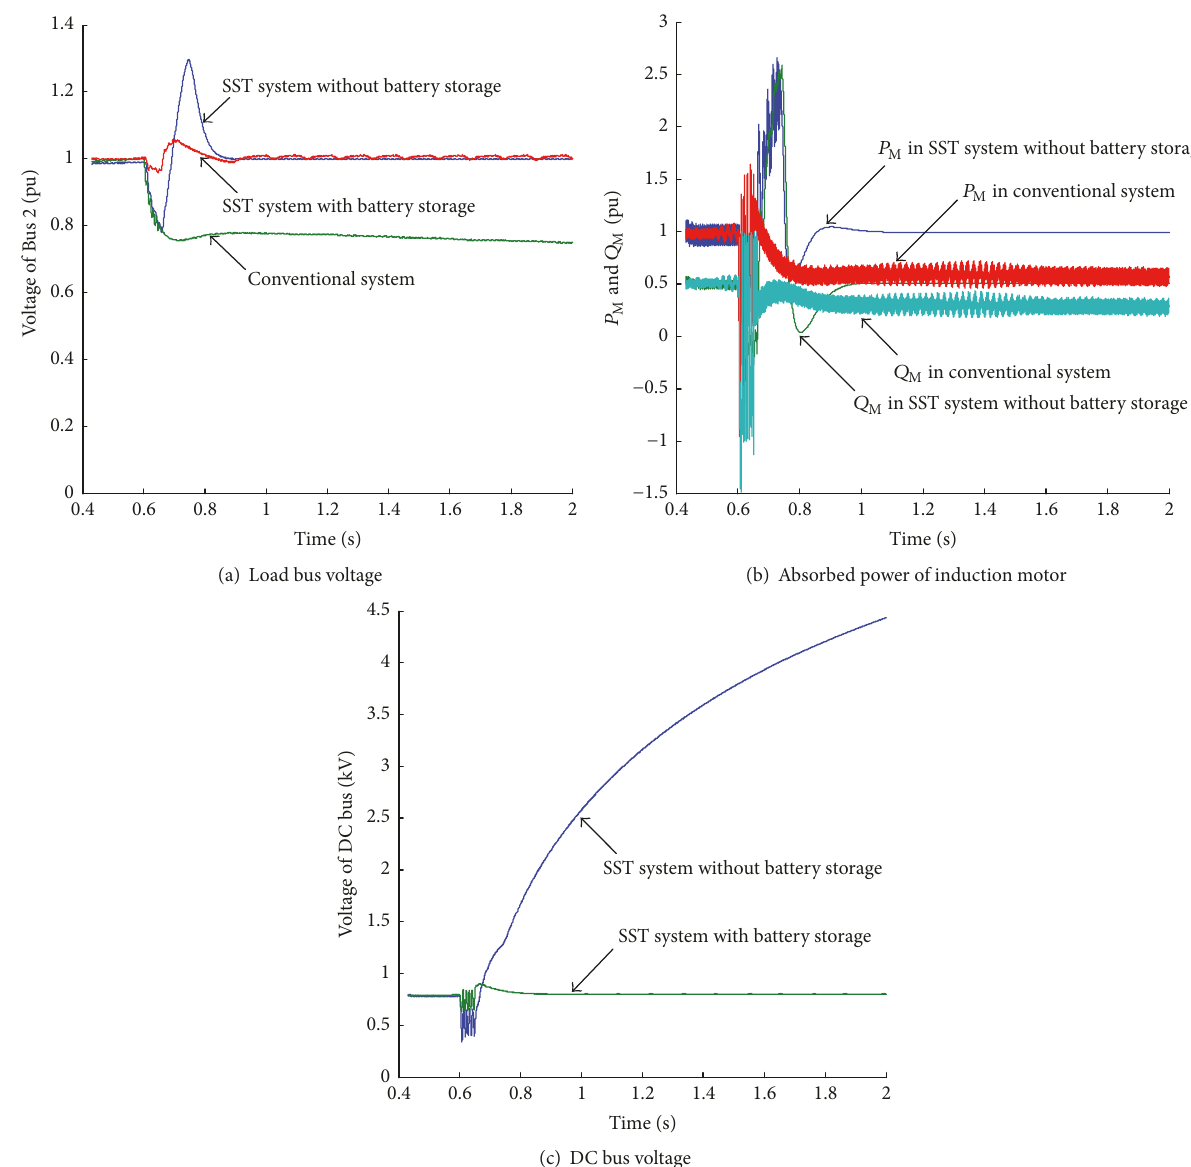
Figure 5: Response curves when single-phase grounding short circuit fault occurs at the midpoint of Line 1.